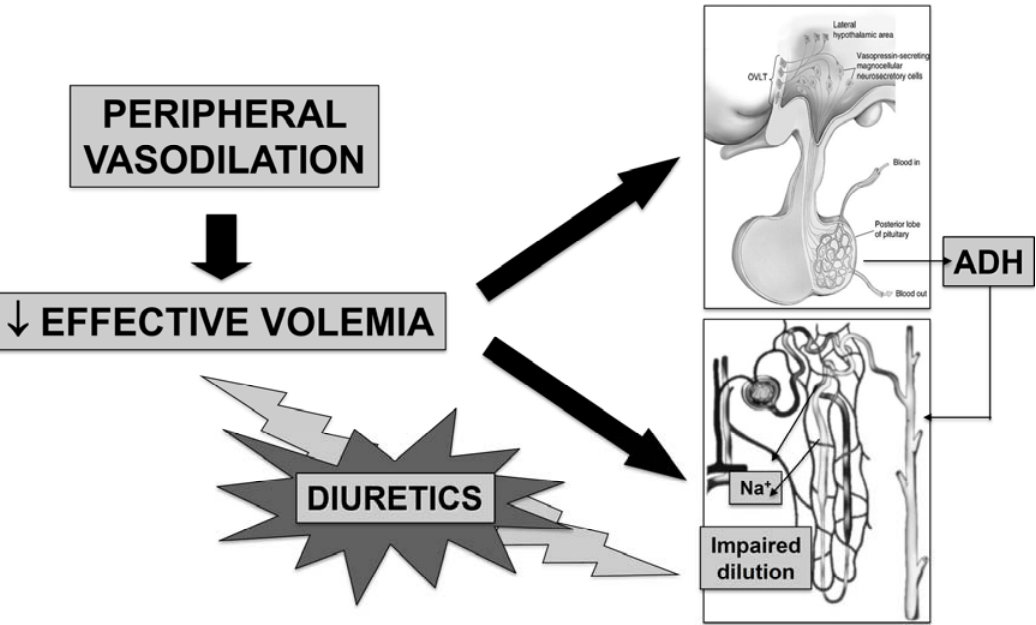
Figure 1. Main mechanisms impairing renal water handling and favoring